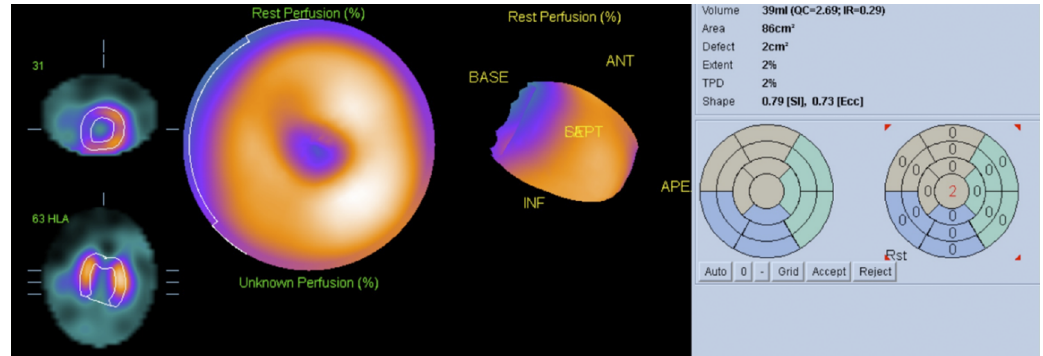
Figure 5. Automatic quantification (polar map) from rest 99m-Technetium sestamibi scintigraphy demonstrating reduced myocardial perfusion in apical region in a patient with a small aneurism of the left ventricular apex.